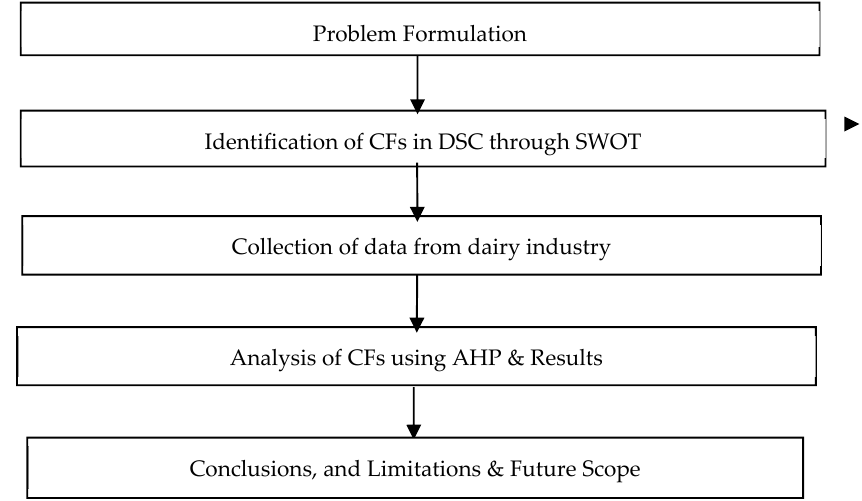
Figure 1. Methodology. Figure 1.